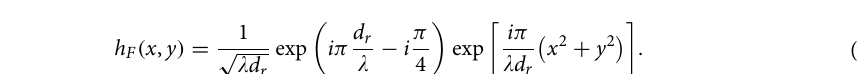
Figure 4. Comparison, for each processing scheme applied to measured data, with, (a) the standard deviation for frequencies 6353.5 Hz, 14,858 Hz, 19,846.5Hz, (b) MAC criterion for the same